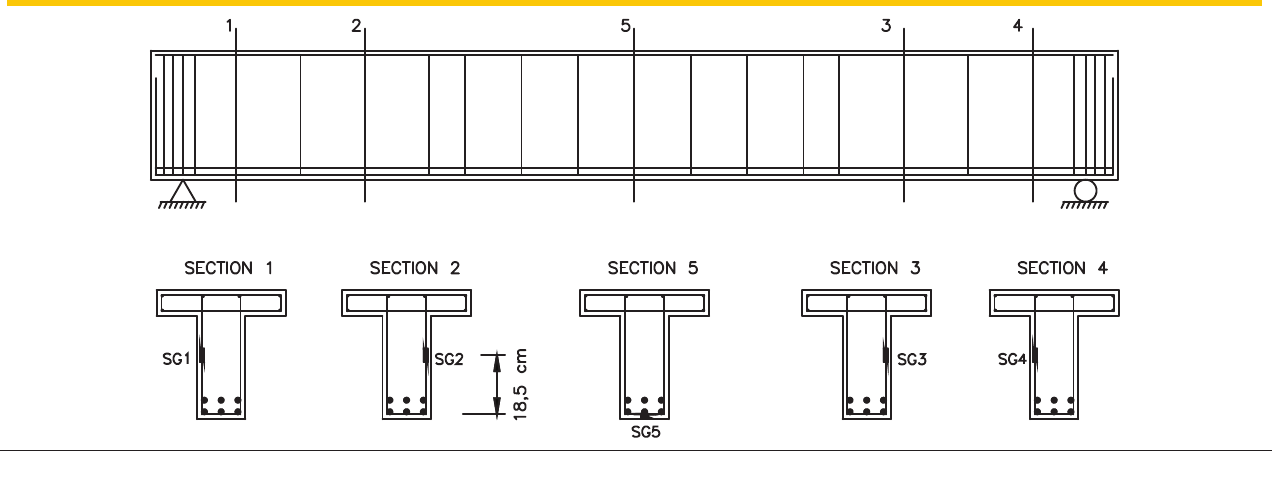
Figure 9 – Strain gauge rosette locations on concrete surface